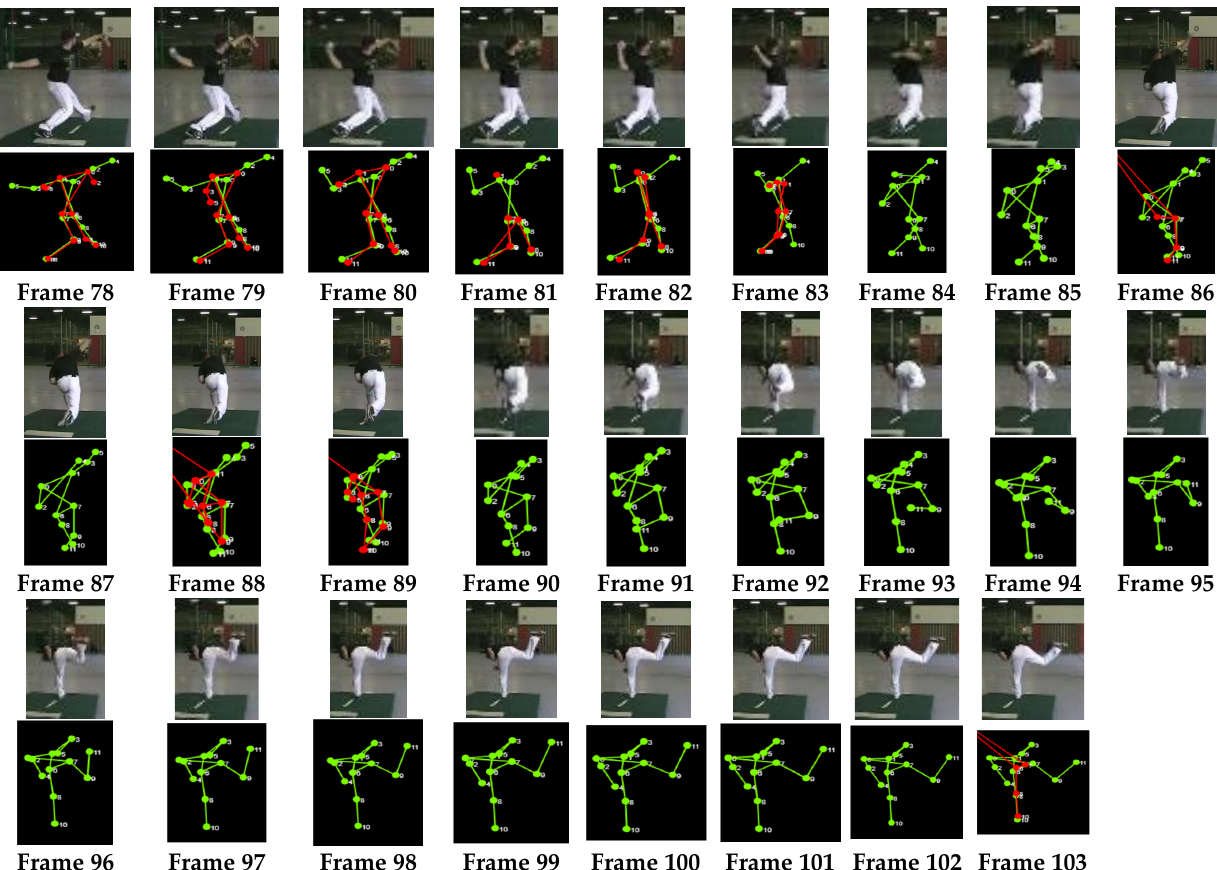
Figure 18. Original images and results from OpenPose from frame 78 to frame 103. Green points and lines represent ground truth, while red points and lines represent OpenPose.